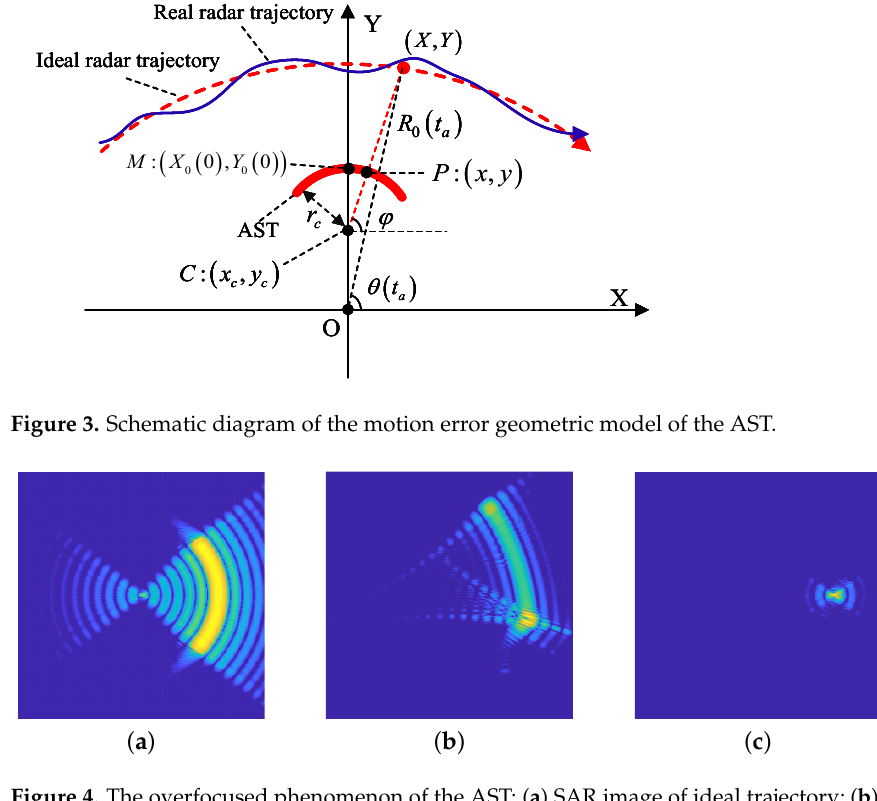
Figure 4. The overfocused phenomenon of the AST: ( a ) SAR image of ideal trajectory; ( b ) SAR image of real trajectory; ( c ) SAR image after applying TAM to ( b